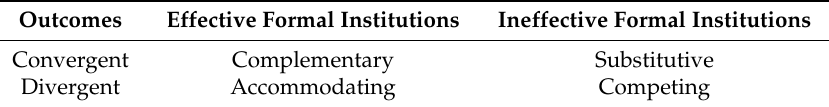
Table 1. A typology of informal institutions [20] (p.